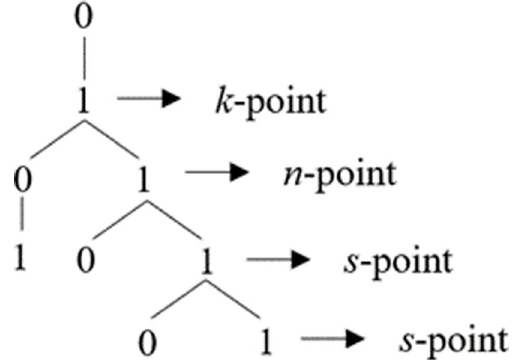
Fig 4. Structural representation of k -points, n -points and s